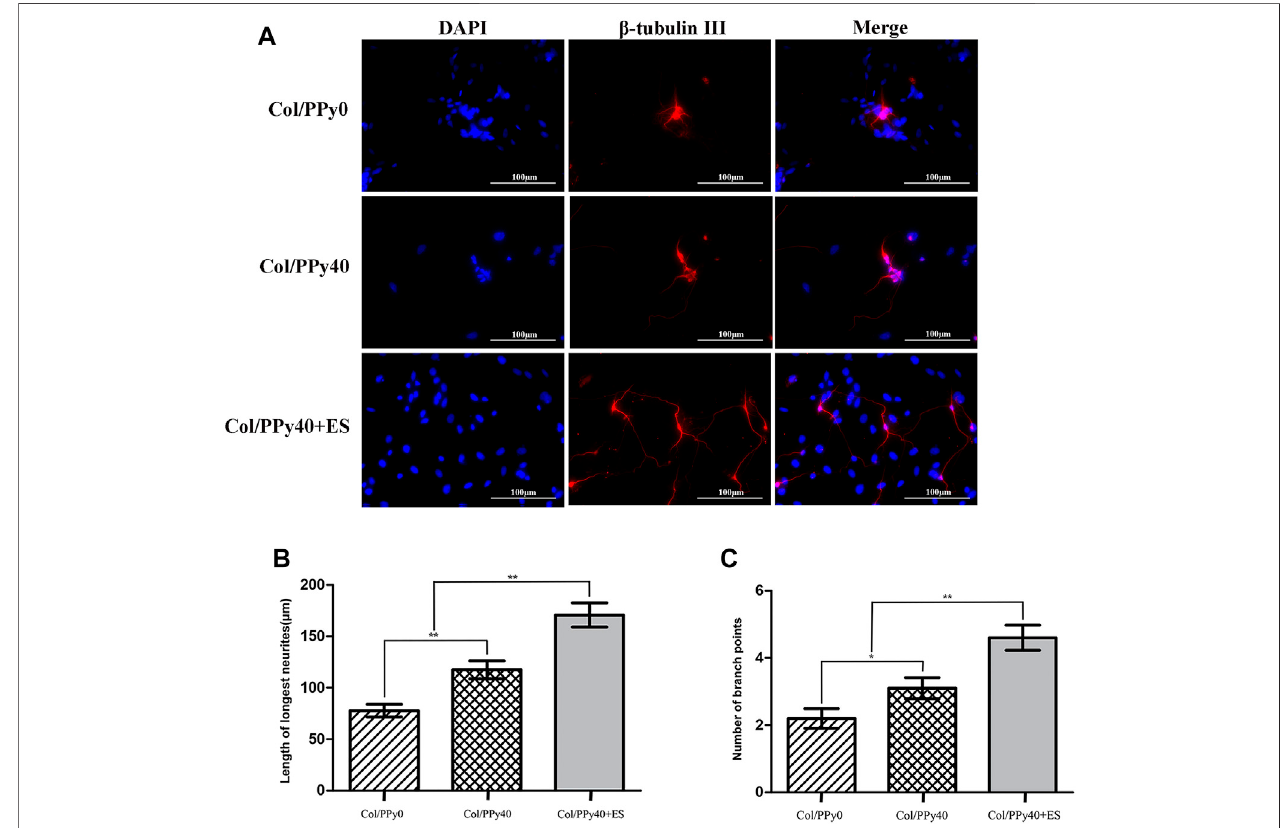
FIGURE 9 | Outgrowth of NSC-derived neurons in Col/PPy0, Col/Ppy40, and Col/PPy40 + ES (200 mV) groups. (A) Representative fl uorescent images of NSC- derived neurons cultured β -tubulin III was stained red, and the nuclei were stained blue; (B) Length of the neurites in different groups. (C) Number of branch points in different